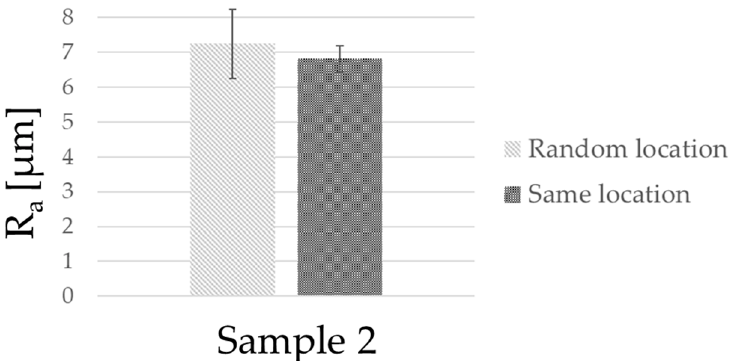
Figure 13. Comparison of results obtained by measuring surface roughness on different edges of the same sample with the VB instrument. The histogram on the left represents measurements performed in random locations, while the histogram on the right represents measurements taken on the same location. The error bars represent the range of the measurements.